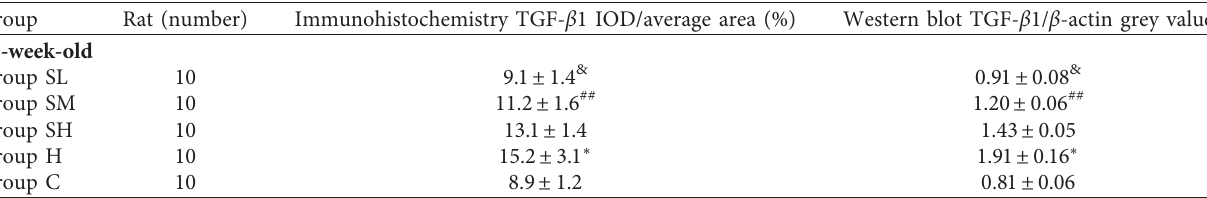
Table 3: The expression of TGF- β 1 in atrial tissue detected by immunohistochemistry and western blot (M ± SD). Group